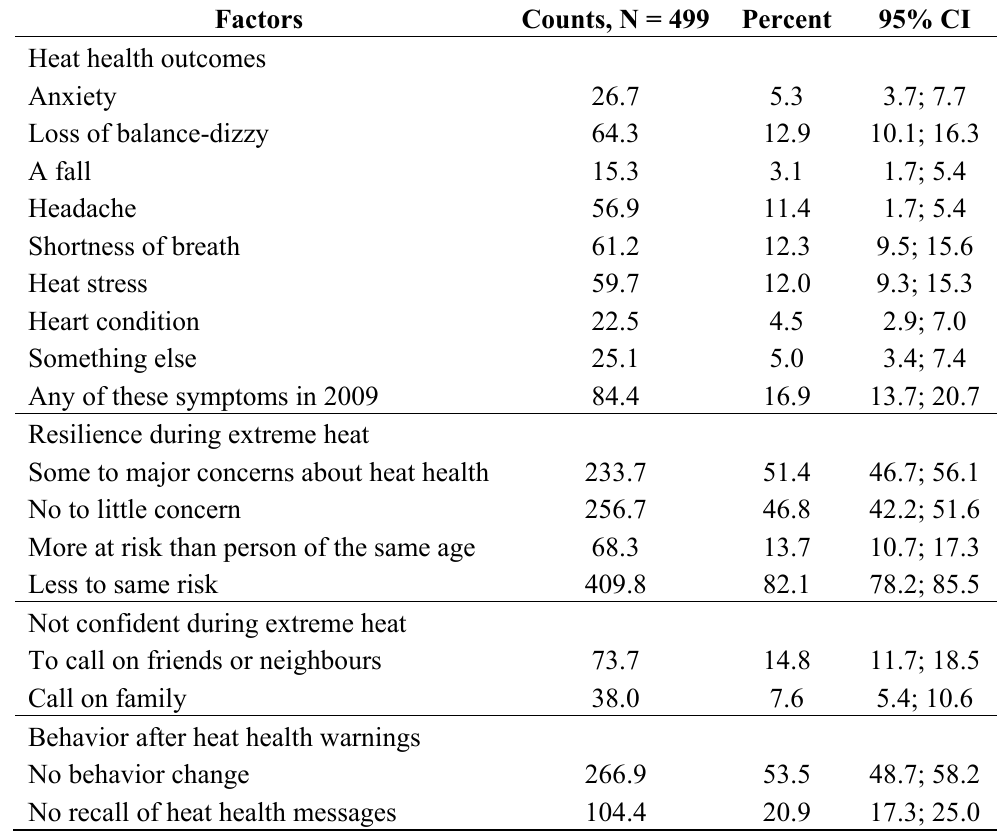
Table 4. Outcome factors (heat health, resilience, social connectedness and recall). Weighted counts, percent and 95%